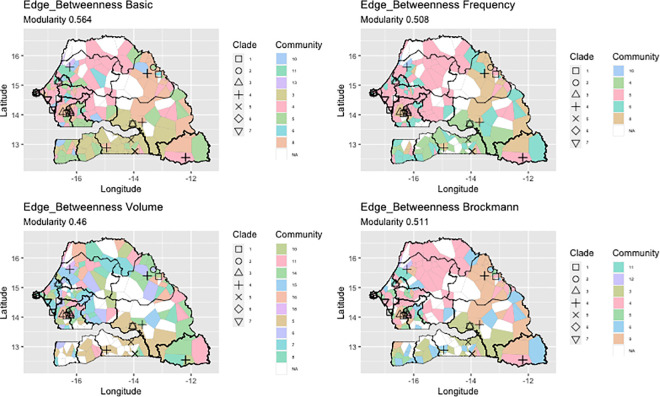
Tessellation of Senegal based on the position of mobility network nodes using the Edge_Betweenness algorithm.Each polygon, centred around nodes of the network, is coloured based on the community it has been associated with (also labelled with an id number in the legend). Only communities where at least one PPRV strain has been detected are shown in colours. Icons indicate different PPRV genetic clades based on results of the phylogenetic analyses. This figure visualizes if spatial structure is present in our network, using the community algorithm Edge Betweenness, with different weights for the links: Basic, no weight; Frequency, the number of times the link was active; Volume, cumulative volume of animals exchanged in a year; Brockmann, using the effective Brockmann distance (see main text). The base layer for the map used in the figure was obtained at http://www.gadm.org.